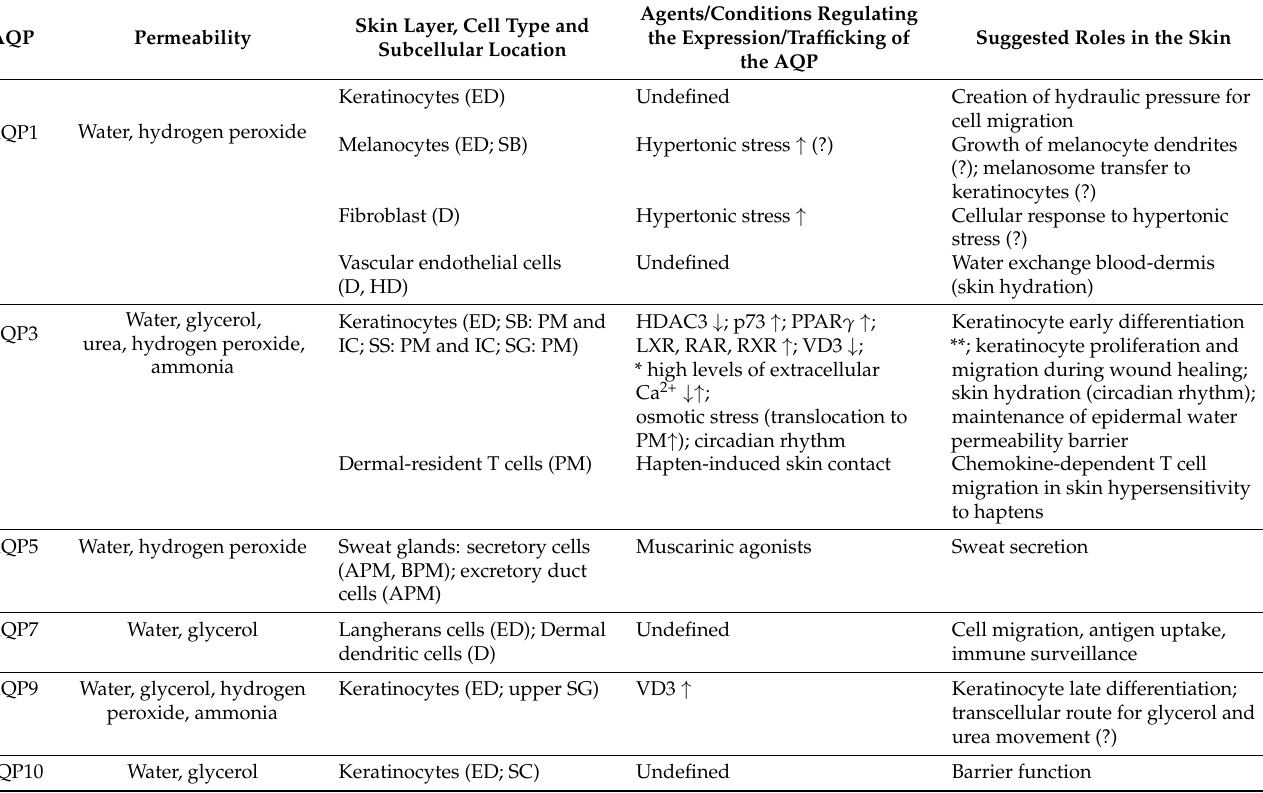
Table 1. Localization, regulation and physiological roles of human/rodent skin